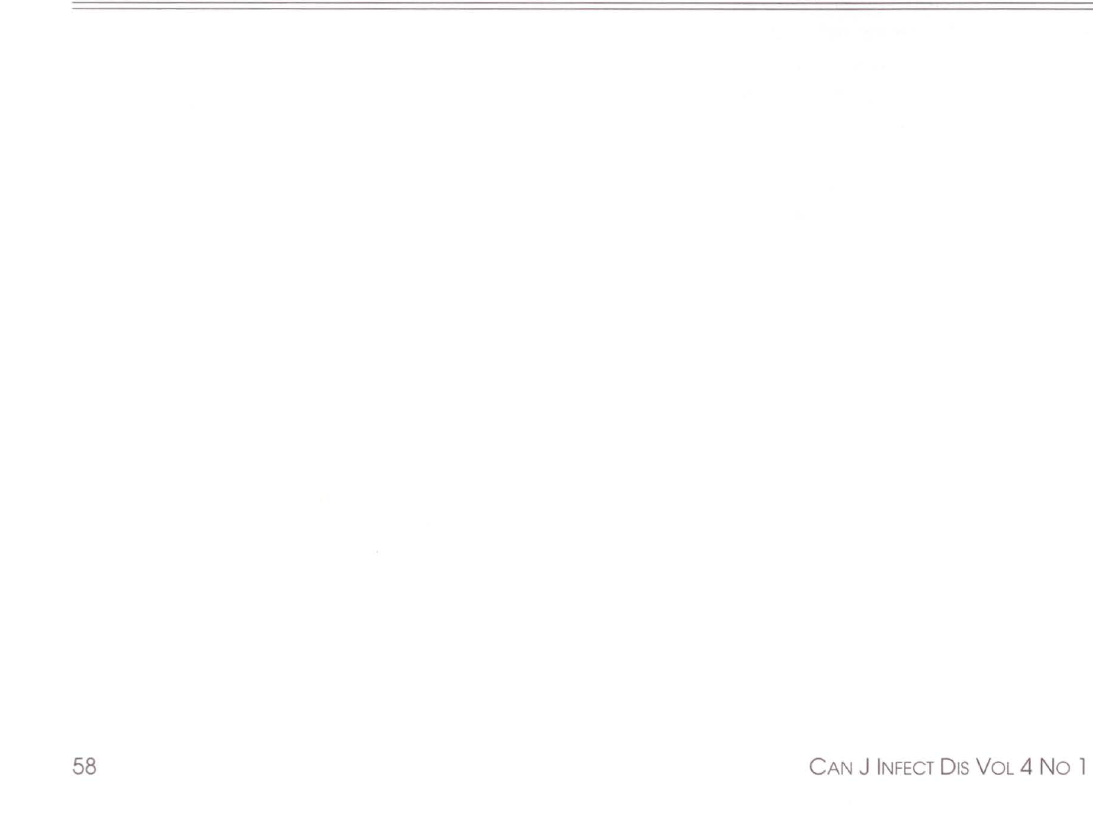
data. The data on AIDS cases are extremely dependent on the cooperation of primary care doctors and nurses, consulting physicians and the medical officers of health in communities throughout Canada. We encourage a renewed effort to keep the data relevant and